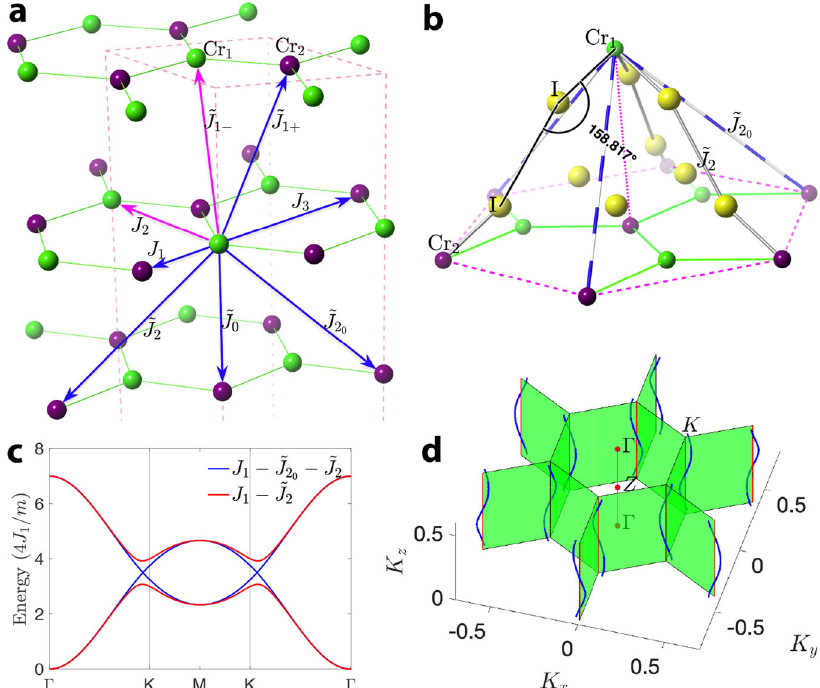
Fig. 3 Exchange parameters, SW spectra, and nodal lines calculated using linear spinwave theory. a Pair exchange parameters for the fi rst few neighbors in R-CrI 3 . b Atomic con fi gurations around the exchange paths of ~ J 2 superexchange coupling. c SW spectra along the Γ – K – M path calculated within a J 1 - ~ J 2 - ~ J 2 model. d Dirac nodal lines, where the magnon bands cross, wind around the K -point and along the calculated in QSGW + U are used.